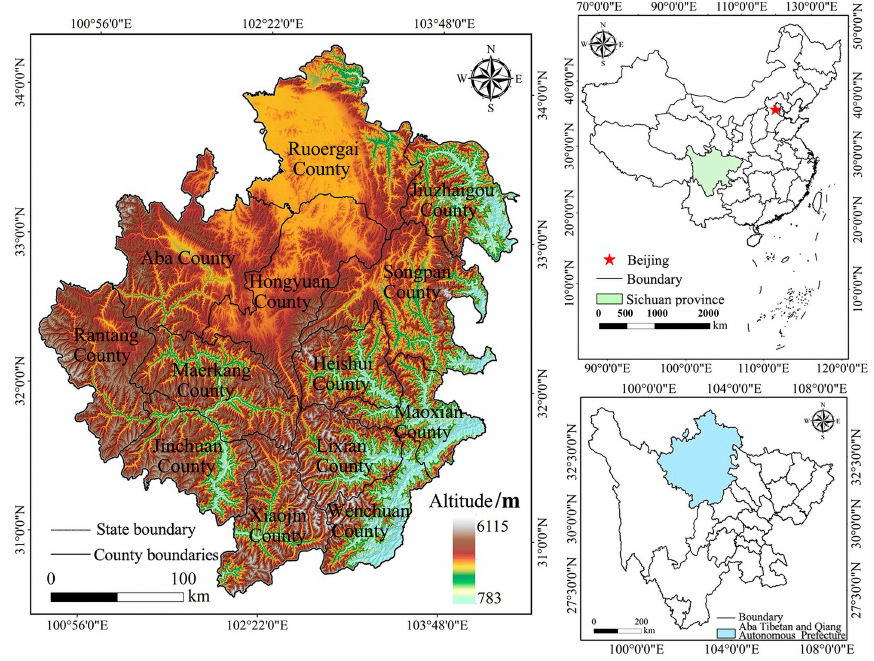
Figure 1. Map of the researched area.